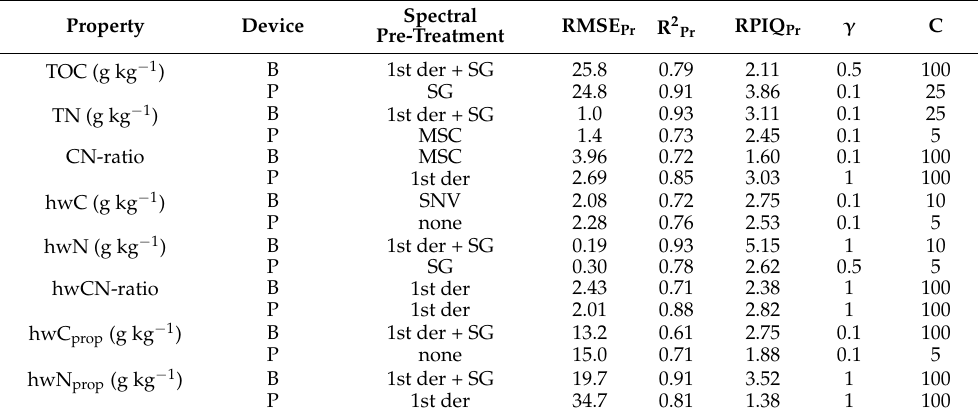
Table 3. Test set validation ( n = 14) statistics and kernel function hyperparameters gamma ( γ ) and cost (C) of SVM models for the prediction of compost and BCS properties using a benchtop MIRS (B) and a portable MIRS (P).